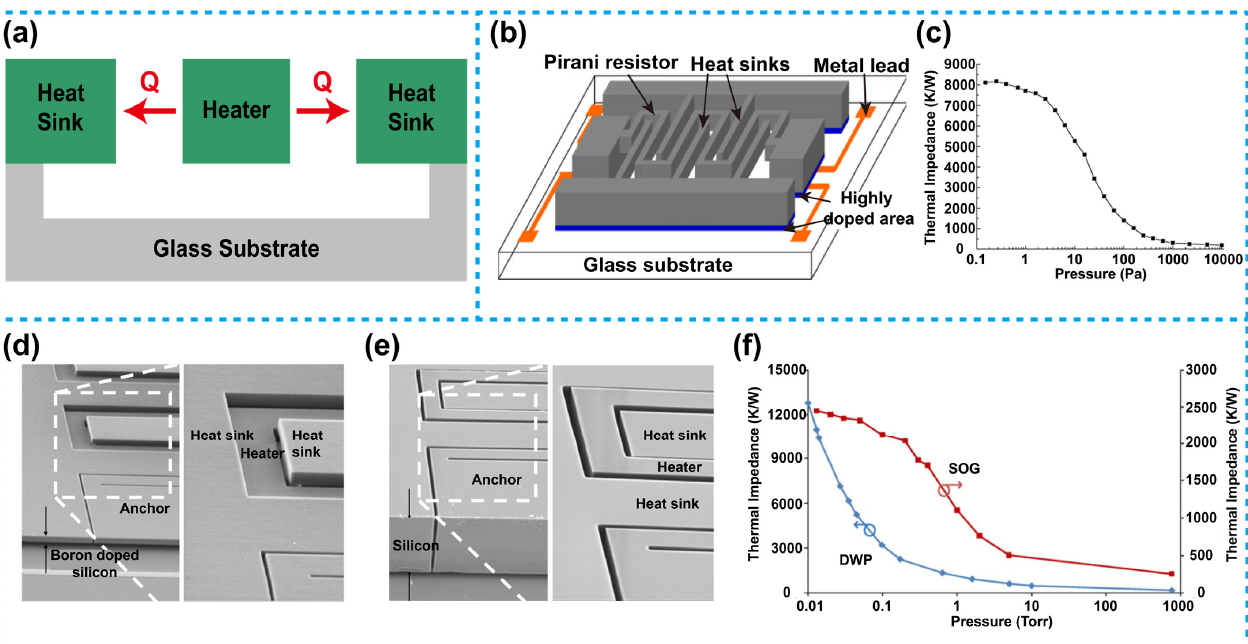
Figure 4. Thermistor-based Pirani sensors using the lateral heat transfer configuration: ( a ) Typical schematics of such a sensor. ( b ) Structure diagram of such a sensor [78]. ( c ) Thermal impedance versus pressure of the sensor mentioned in ( b ), the sensitive range of the device was 1 to 1000 Pa. ( d ) SEM image of the DWP sensor. ( e ) SEM image of the SOG device [79]. ( f ) Thermal impedance versus pressure of the DWP and SOG sensors mentioned in ( d , e ), showing the different sensitive ranges of the two devices.